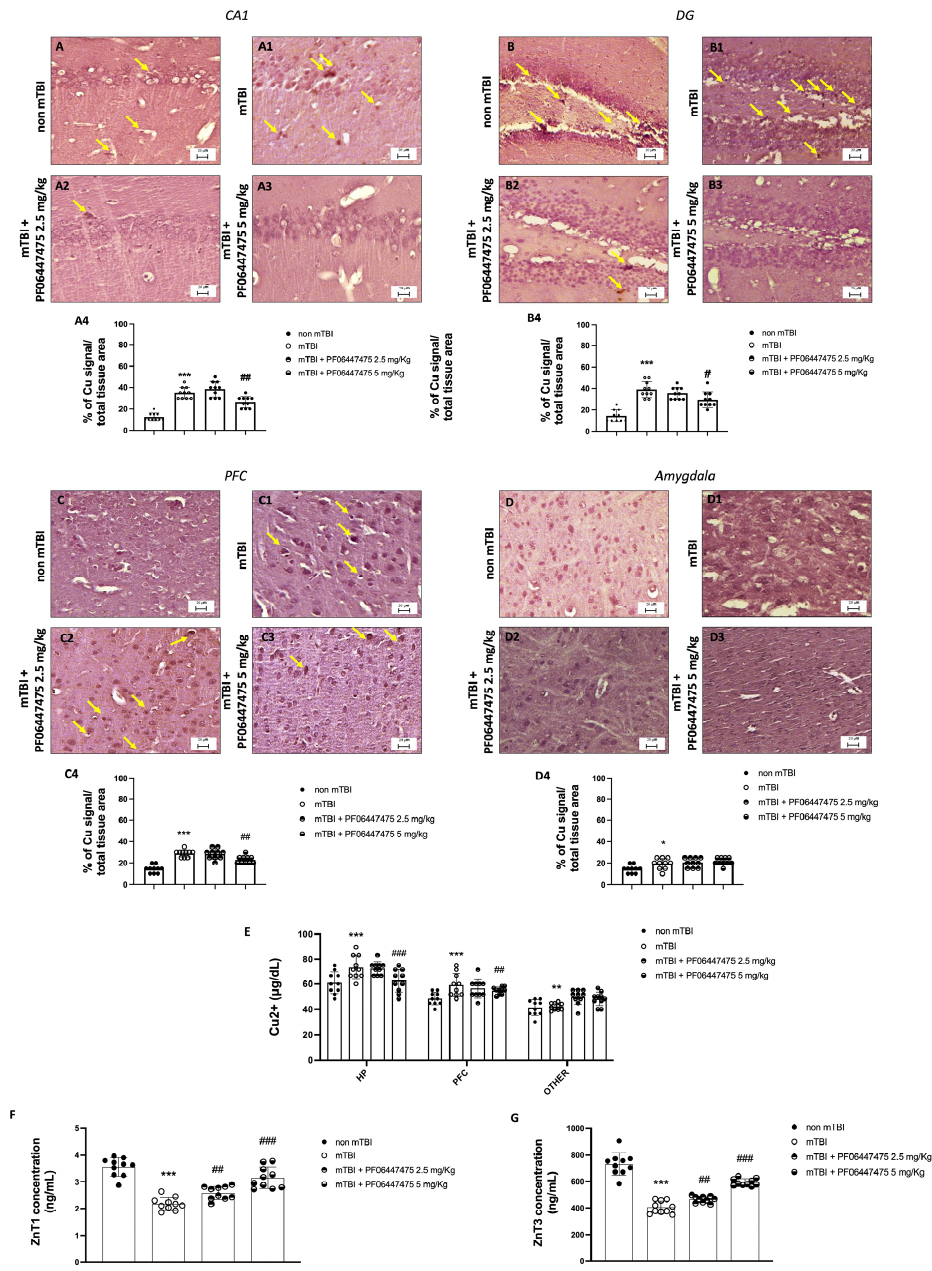
Figure 2. Effects of PF-475 treatments on Cu uptake after mTBI in the CA1, DG, PFC and amygdala areas. CA1 area: copper staining of the non-mTBI group ( A ) and the mTBI group ( A1 ), see percentage of Cu signal over the total tissue area ( A4 ). PF-475 2.5 mg/kg ( A2 ) and 5 mg/kg ( A3 ), see percentage of Cu signal over the total tissue area ( A4 ). DG area: copper staining of the non-mTBI group ( B ) and the mTBI group ( B1 ), see percentage of Cu signal over the total tissue area ( B4 ). PF-475 2.5 mg/kg ( B2 ) and 5 mg/kg ( B3 ), see percentage of Cu signal over the total tissue area ( B4 ). PFC area: copper staining of the non-mTBI group ( C ) and the mTBI group ( C1 ), see percentage of Cu signal over the total tissue area ( C4 ). PF-475 2.5 mg/kg ( C2 ) and 5 mg/kg ( C3 ), see percentage of Cu signal over the total tissue area ( C4 ). Amygdala area: copper staining of the non-mTBI group ( D ) and the mTBI group ( D1 ), see percentage of Cu signal over the total tissue area ( D4 ). PF-475 2.5 mg/kg ( D2 ) and 5 mg/kg ( D3 ), see percentage of Cu signal over the total tissue area ( D4 ). Copper accumulation ( E ). The concentration of ZnT1 and ZnT3 in brain tissues ( F , G ). Data are expressed as SD from 10 mice for each group. Two-way ANOVA test. * p < 0.05, ** p < 0.01 and *** p < 0.001 vs. non mTBI; # p < 0.05, ## p < 0.01 and ### p < 0.001 vs.